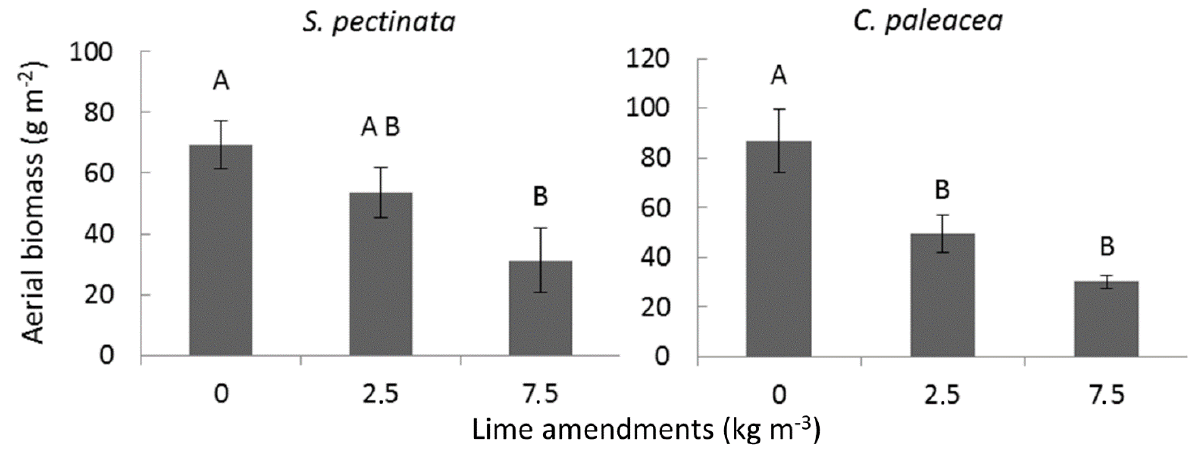
Figure 5. Effects of dolomitic lime treatments on S. pectinata and C. paleacea aerial biomass after four months of growth in the greenhouse (mean ± SE) ( n = 15). Different letters indicate significant differences following protected LSD. See Table A4 for results of the statistical analyses.